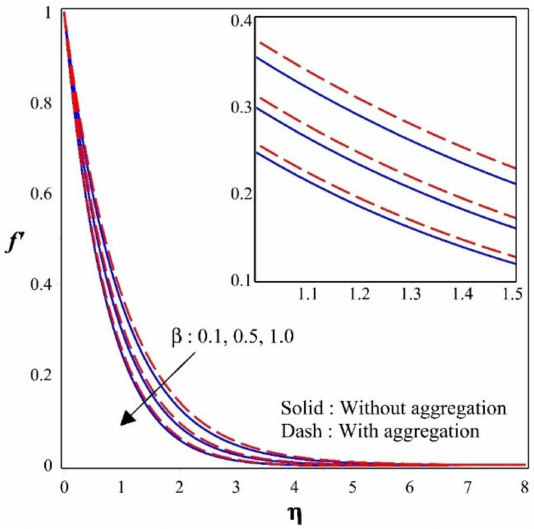
Figure 2. Sway of f (cid:48) for different values of β . Figure 3 demonstrations the influence of micropolar constraint α 1 over a velocity f